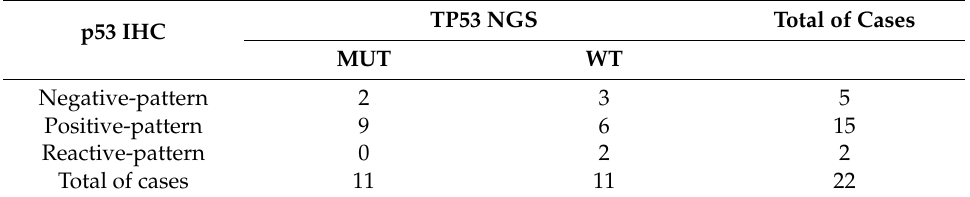
Table 3. Comparative data between p53 phenotype and TP53 genotype in PSRT tumor samples.